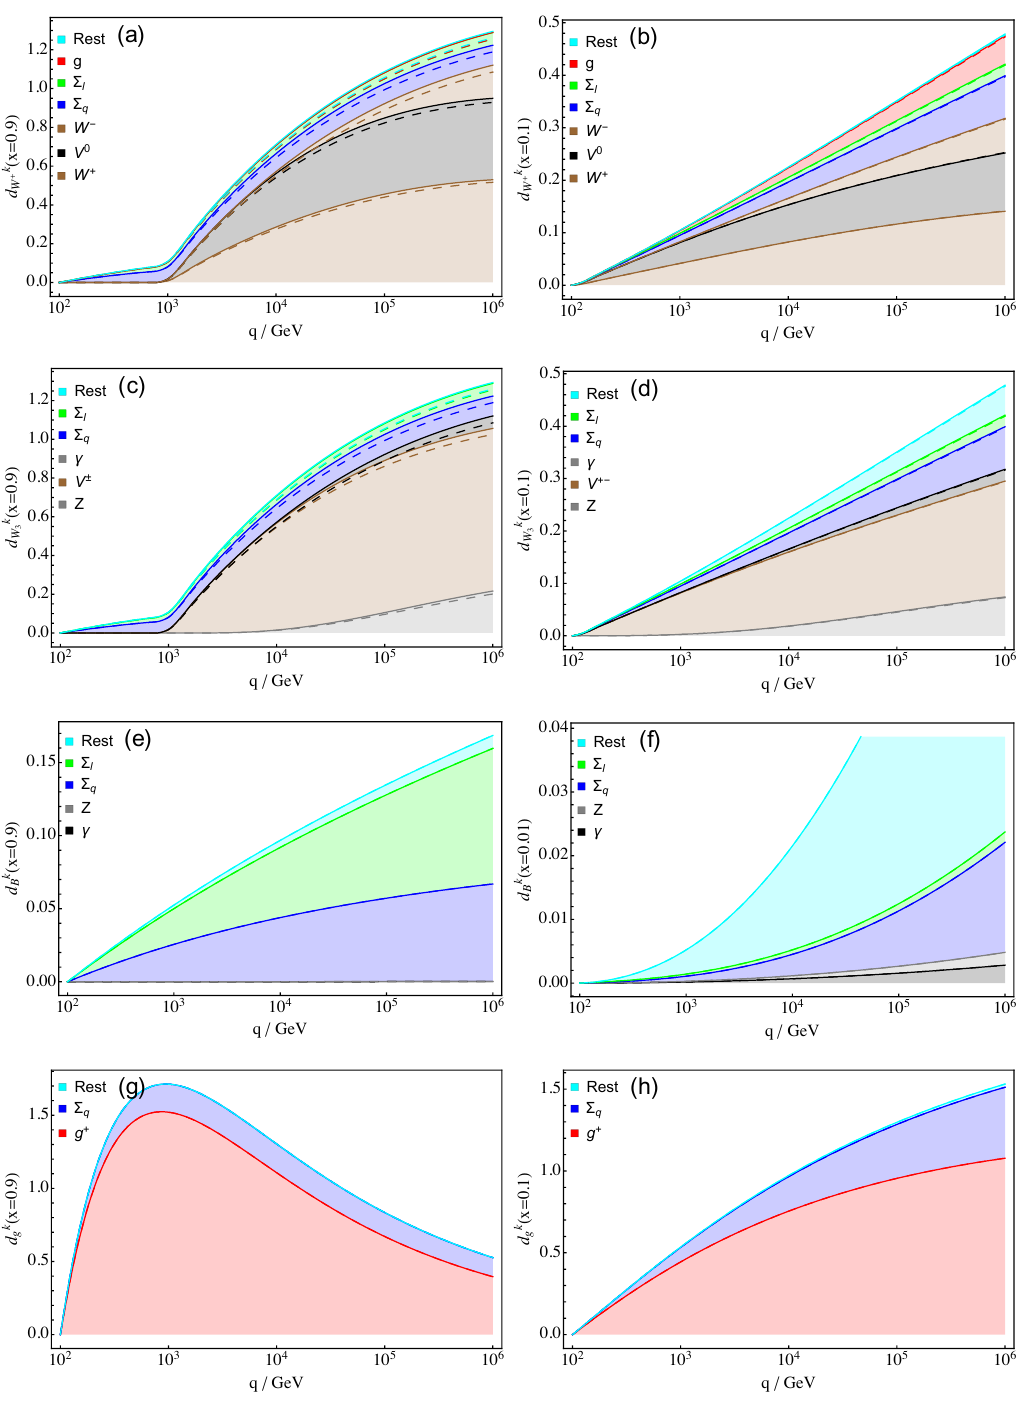
Figure 3 . The fragmentation functions for (left) x = 0 : 9 and (right) x = 0 : 1 for (a,b) i = W + , (c,d) W 3 , (e,f) B , (g,h) g . The di(cid:11)erent values of k are stacked on top of each other. Dashed/solid lines show DL/NLL resummed